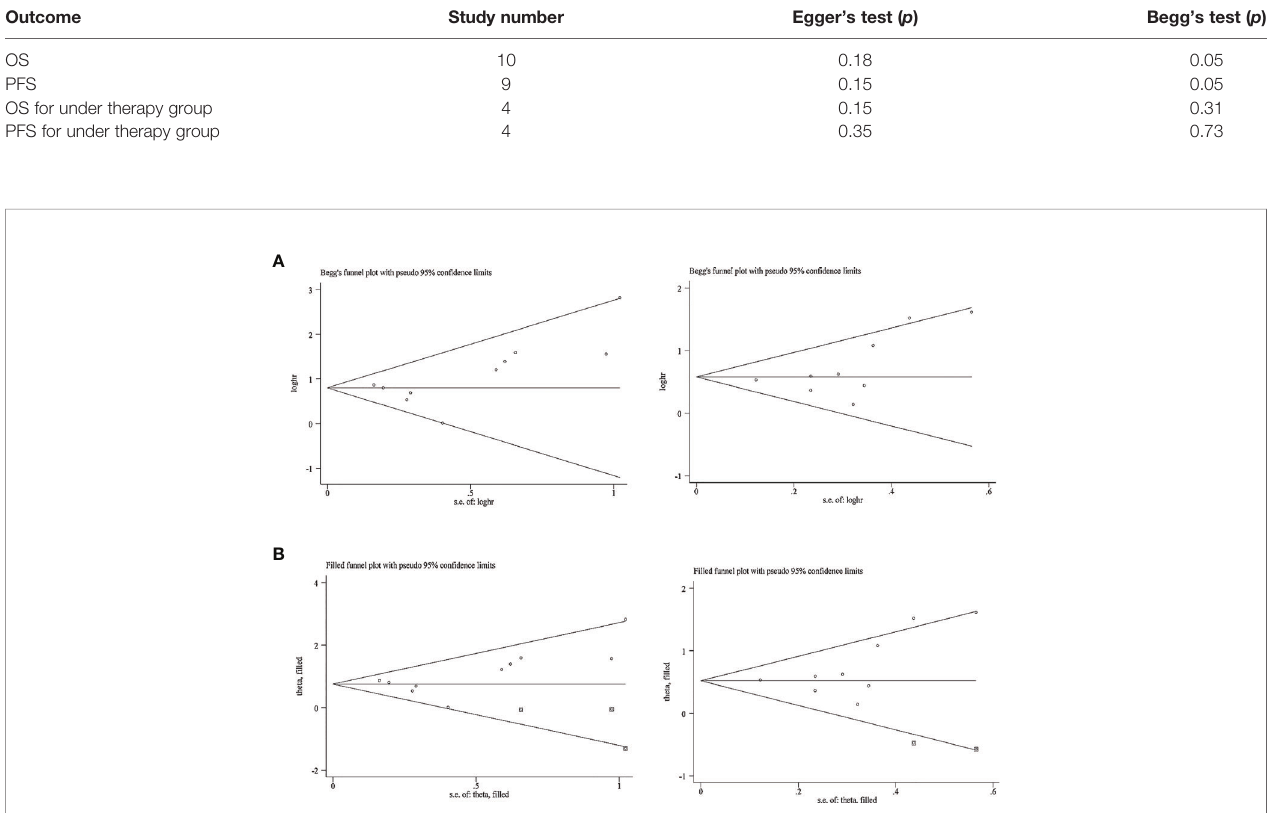
FIGURE 6 | Funnel plot for the evaluation of publication bias considering the association between the neutrophil-to-lymphocyte ratio at baseline or pre-therapy and clinical outcomes in this analysis. (A) Funnel plot for 10 studies regarding overall survival and 9 studies considering progression-free survival before the “ trim and fi ll ” method. (B) Funnel plot for 10 studies considering overall survival and 9 studies considering progression-free survival after the “ trim and fi ll ”